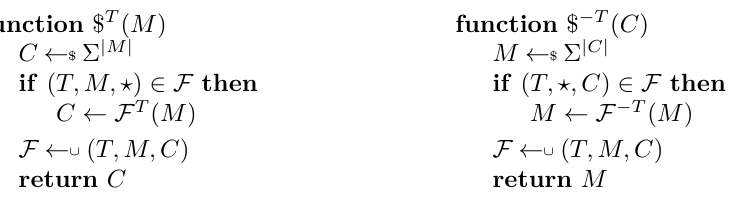
Figure 2: A lazily sampled tweakable random function with inverse, with internal table F